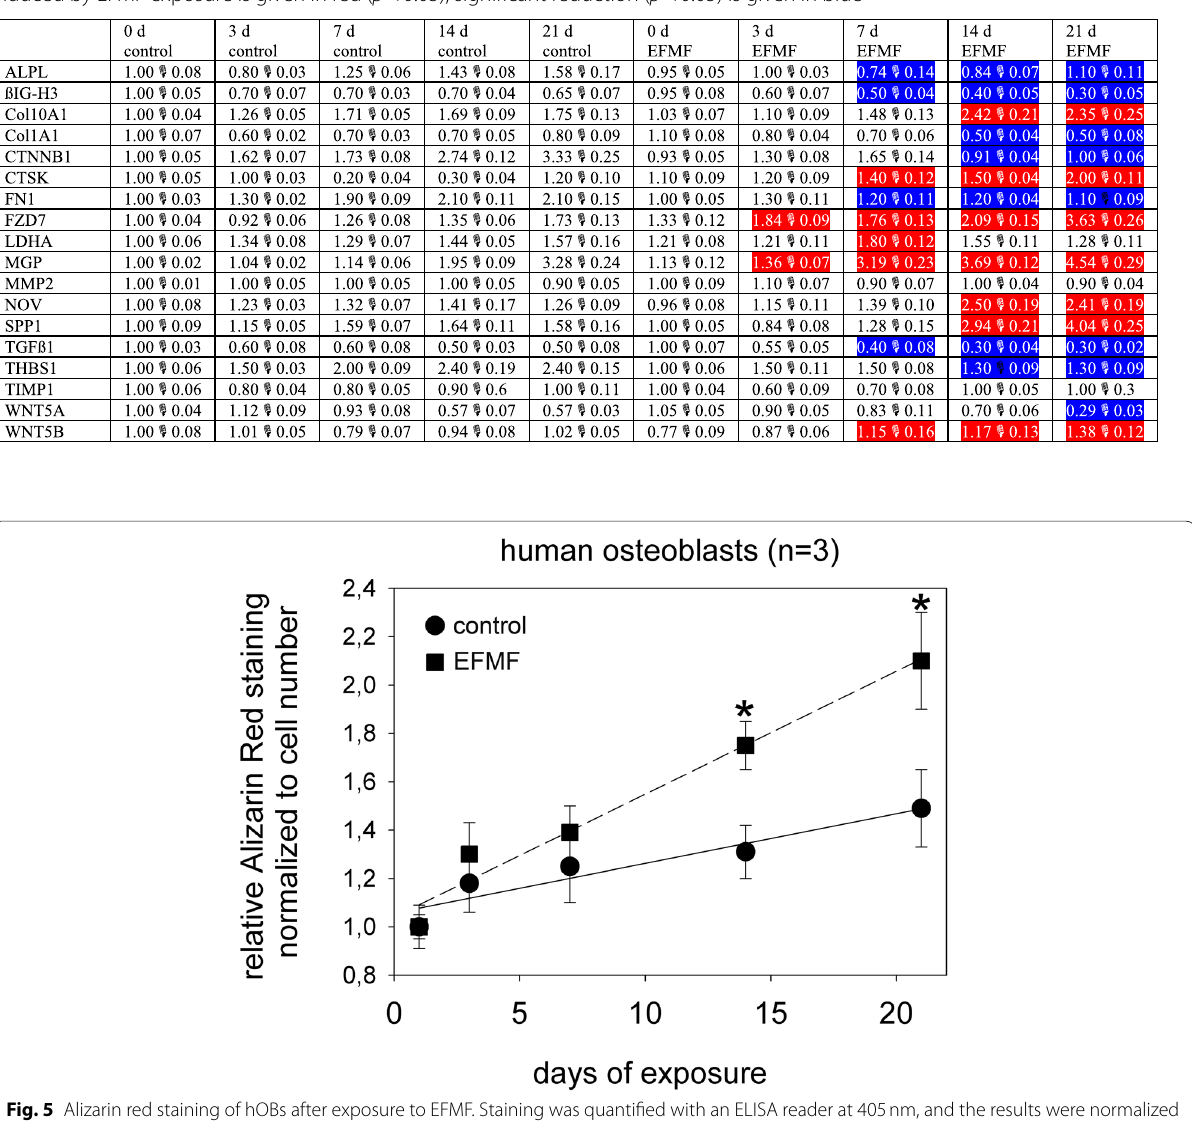
Table 2 The fold protein expression of Fig. 4 is given below as mean of 3 independent experiments (